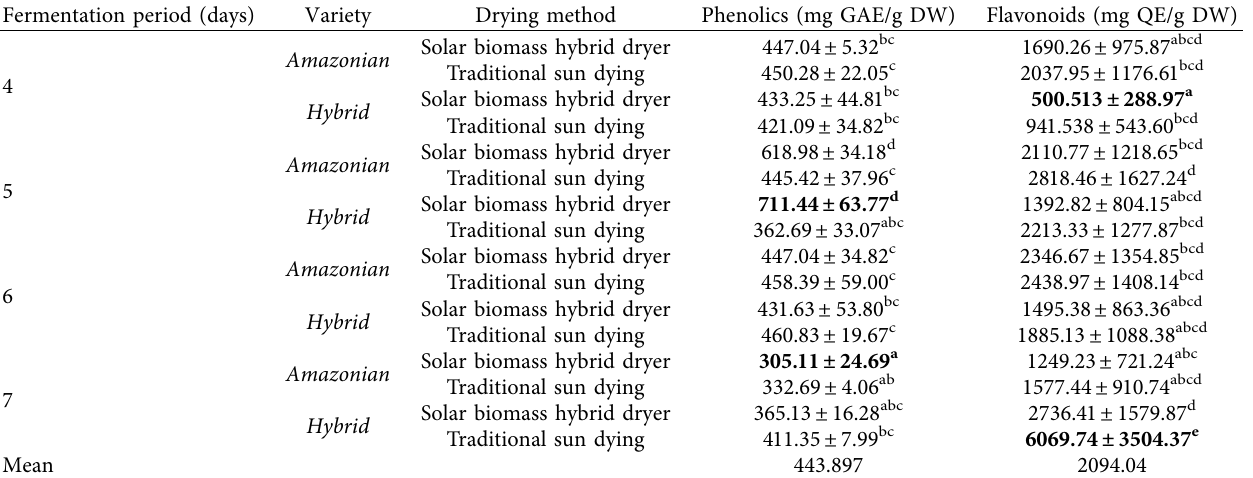
Table 3: Total phenolics and flavonoids in cocoa varieties under different fermentation and drying periods. Fermentation period (days)